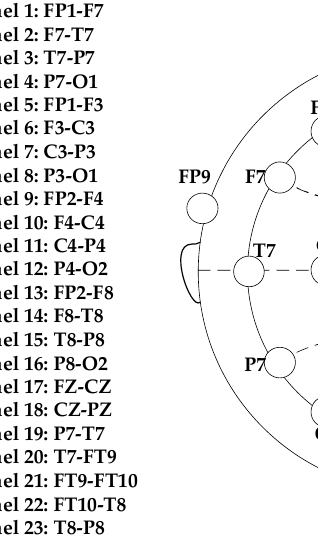
Figure 2. This figure shows the placement of the EEG electrodes.